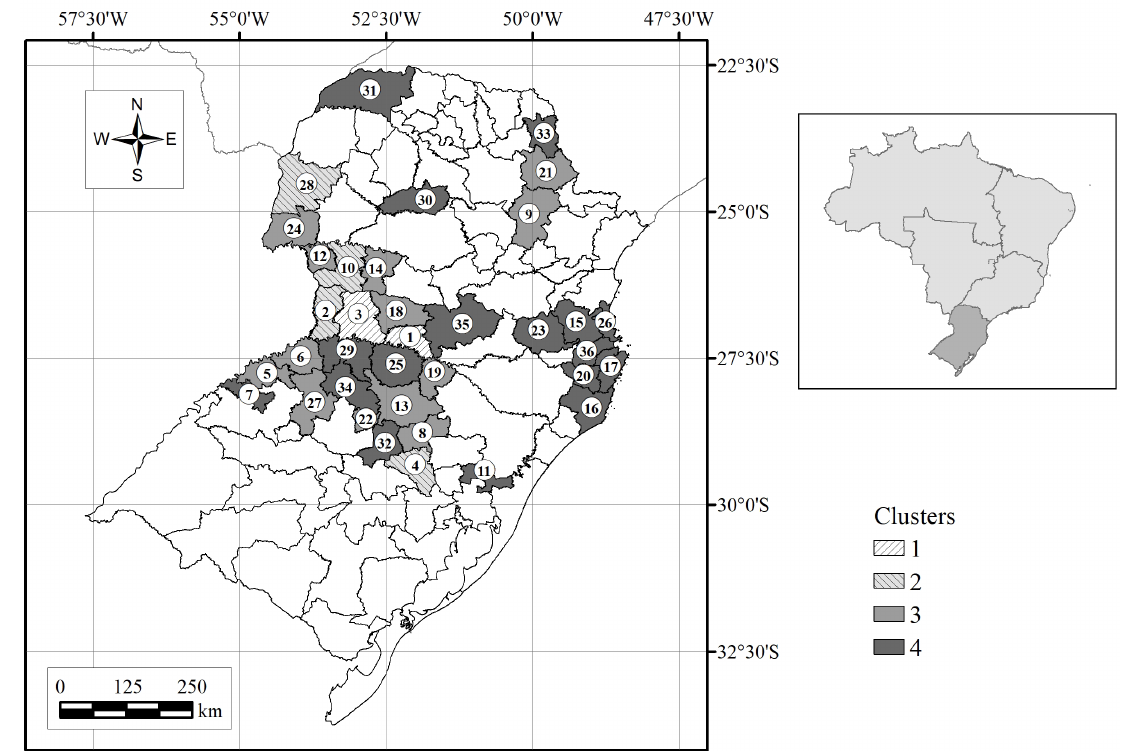
Figure 3. Clustering of microregions specialized in milk production in Southern Brazil. Notes: 1.